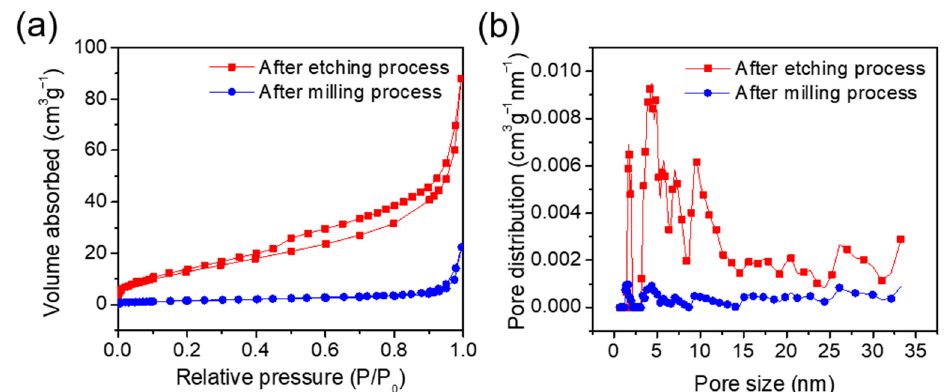
Figure 4. ( a ) N 2 adsorption and desorption isotherm and ( b ) pore size distribution before and after etching.